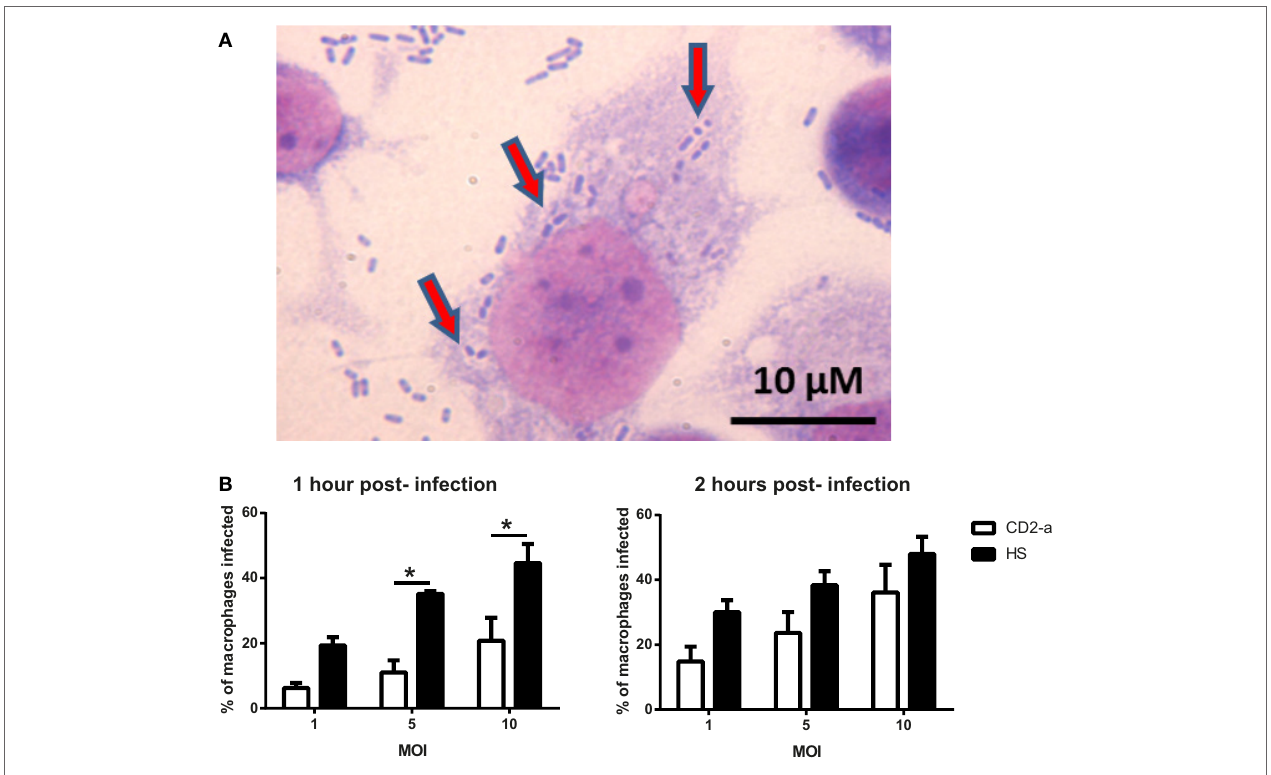
FigUre 6 | THP-1 macrophage infection depends on the multiplicity and duration of infection. Giemsa stain was used to determine bacterial counts inside macrophages. (a) Representative image of THP-1 macrophages infected with strain CD2-a. Red arrows show what appear to be Escherichia coli inside vacuoles in the cytoplasm. (B) Quantification of presumed infected macrophages shows that the level of infection (as a proportion) is dependent on the multiplicity and duration of infection. One-way ANOVA and Bonferroni corrections were performed ( n = 3; p <